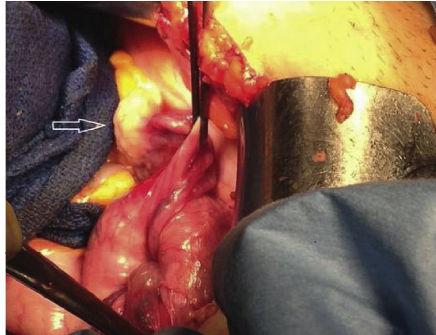
Figure 3: The appearance of ovaries and tubes projecting out of the indented uterine fundus has been described as the “flower vase appearance” in cases of nonpuerperal uterine inversion